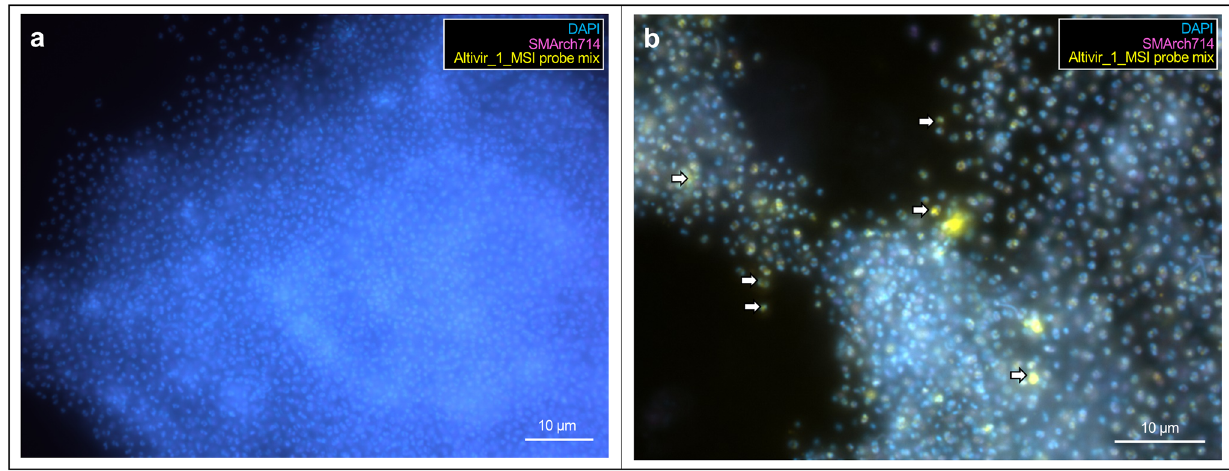
Fig. 5 VirusFISH of two individual Altiarchaeota bio fi lm (BF) fl ocks depicting a) a dense BF fl ock without infections and b) one highly infected BF fl ock. For all virusFISH experiments, an Altivir_1_MSI probe was used for detecting viral infections. White arrows indicate exemplary virus – Altiarchaeota interactions (advanced infections). BF material was analyzed with fi lter sets for DAPI (blue, cells), ATTO 488 (purple, 16S rRNA signal), and Alexa 594 (yellow, viral genomes), and then the different fl uorescent channels were merged for analysis and display purposes. For unmerged imaging data, see Supplementary Figs. 16 and 17. Scale bars: 10 µ